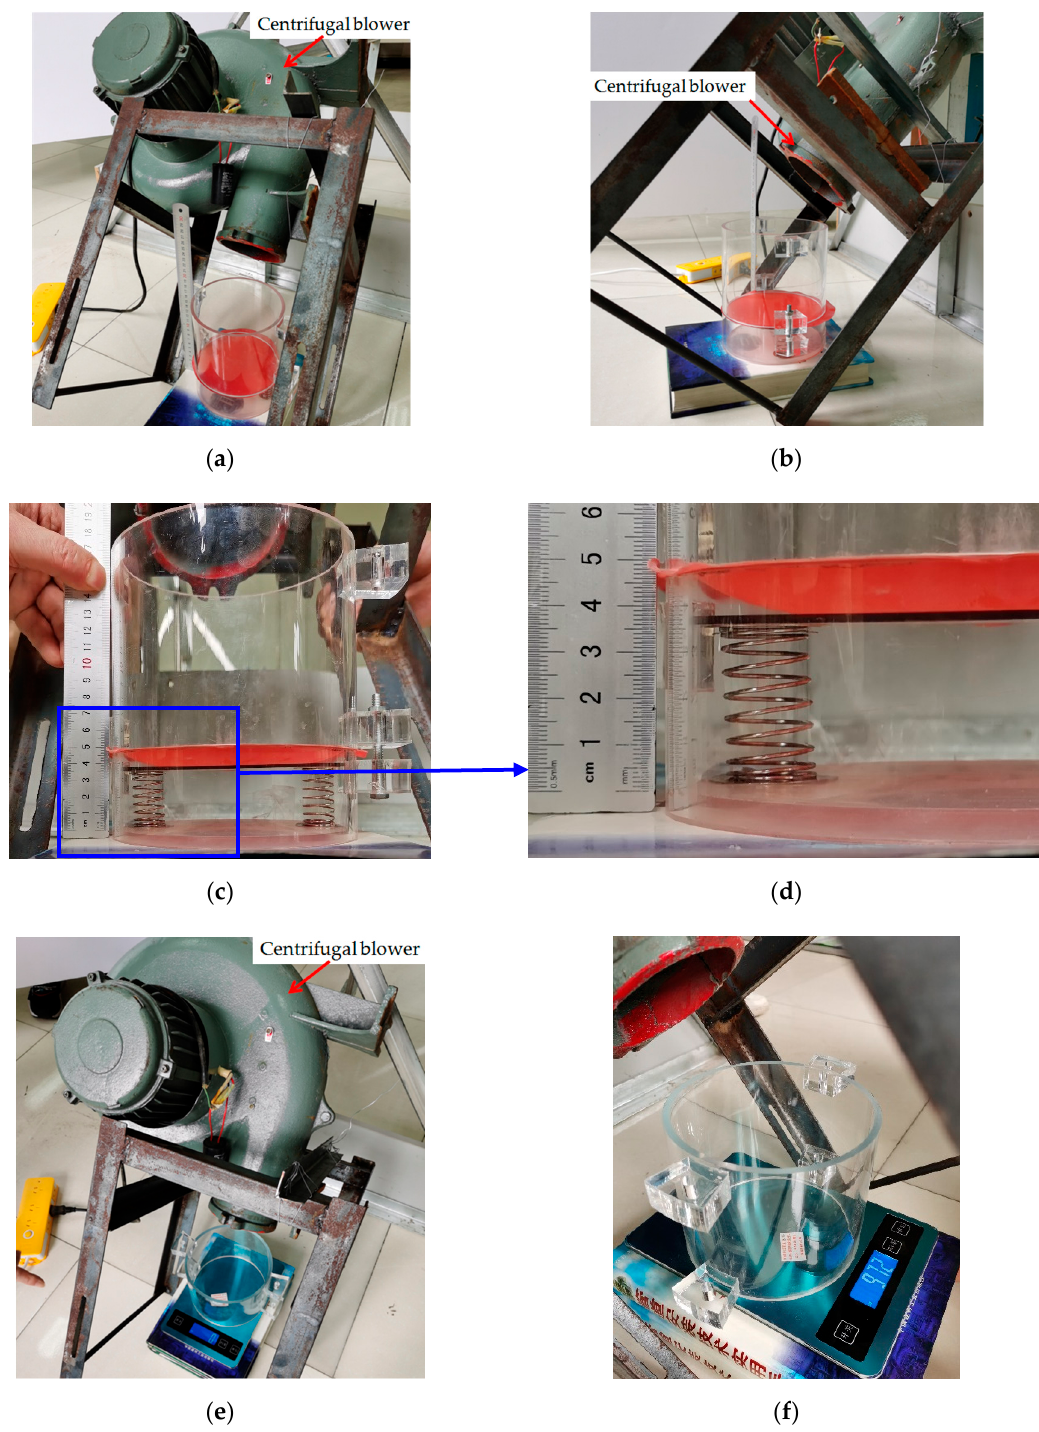
Figure 7. Experimental loading under inclining the centrifugal blower about 45 degrees. ( a – d ) The case of loading the thin film, where ( a ) full view and ( b – d ) enlarged view; ( e – f ) The case of loads measurement, where ( e ) full view and ( f ) enlarged view.